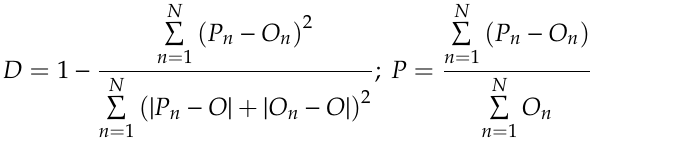
Figure 5. Locations of tide stations and wave buoys.